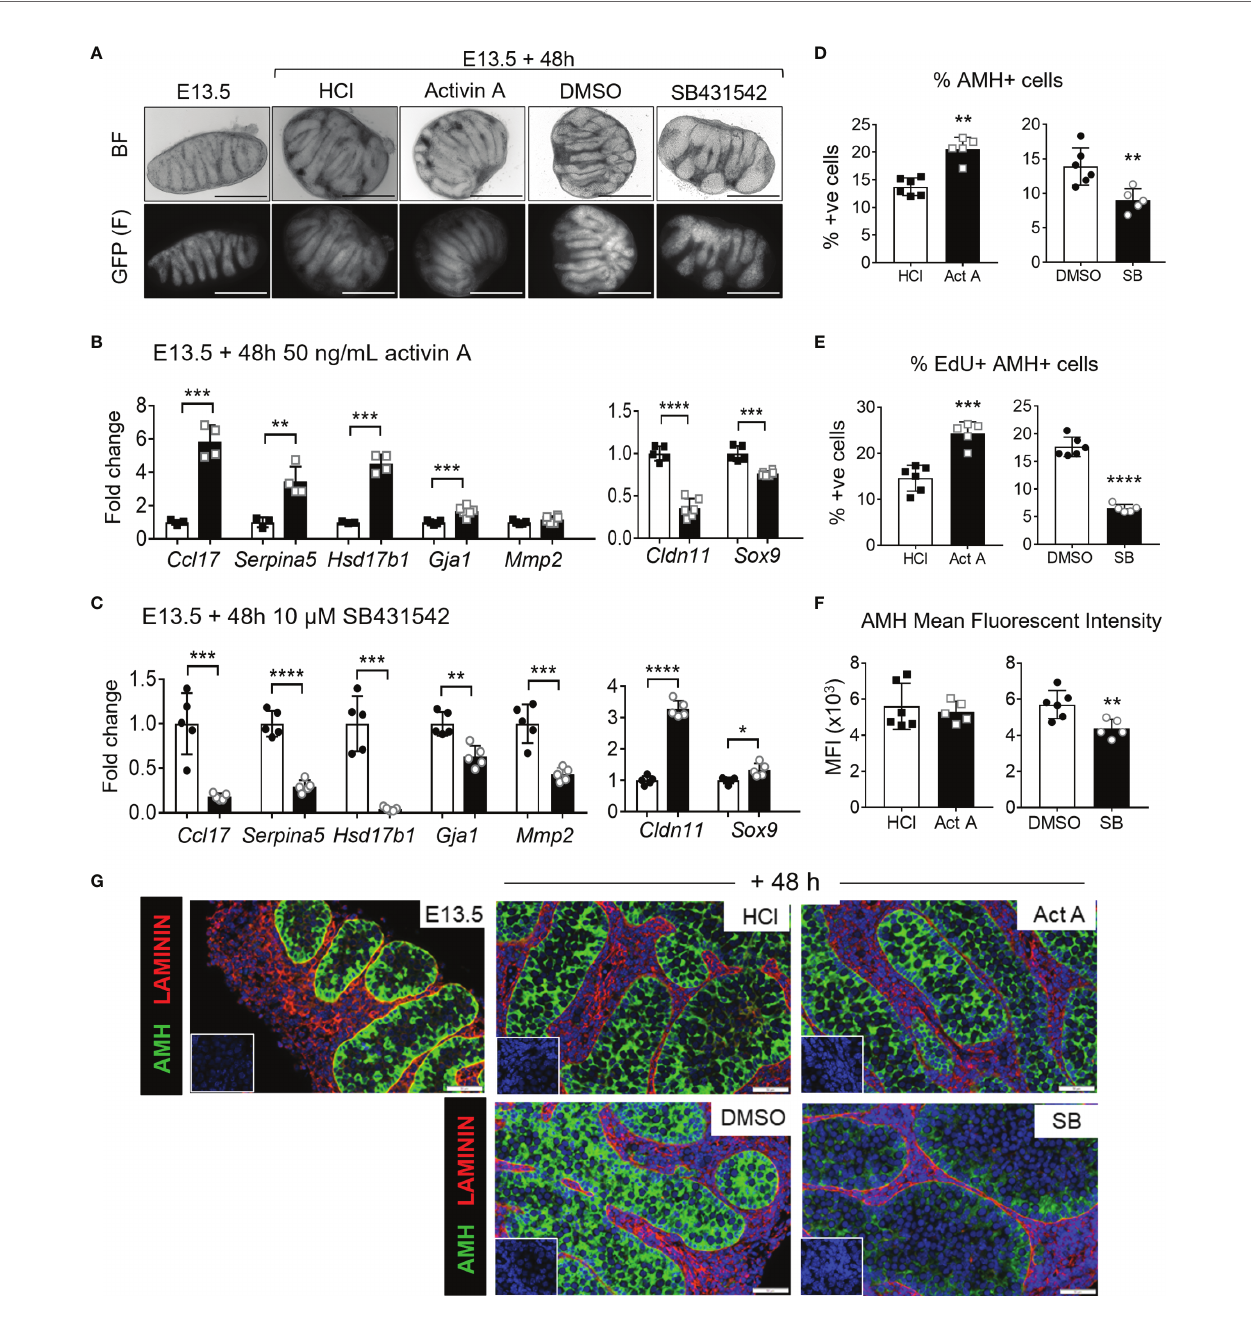
FIGURE 5 | Acute activin A and SB431542 effects on fetal testicular somatic cells. E13.5 testes were cultured for 48 hours on membranes. (A) Representative bright fi eld (top panel) and fl uorescent (GFP, bottom panel) images of E13.5 testis and E13.5 testes cultured 48 h with 50 ng/mL activin A, 10 µM SB431542, or vehicle controls (HCl and DMSO respectively). (B) Somatic cell transcripts of individual testes (n=3-5 per group) cultured for 48 hrs with 50 ng/mL activin A (black bars) compared with control (white bars). (C) Somatic cell transcripts of individual testes (n=3-5 per group) cultured for 48 hrs with 10 µM SB431542 (black bars) compared with control (white bars). All transcripts were measured by qRT-PCR and data normalised to Canx housekeeper. (D – F) Flow cytometry analysis of dissociated E13.5 testes cultured with 50 ng/mL activin A or 10 µM SB431542 for 48 hrs compared with controls. Proportion of (D) AMH-positive (Sertoli) cells, (E) EdU-positive AMH-positive (proliferating Sertoli) cells, and (F) mean fl uorescent intensity (MFI) of AMH-positive population. (G) Representative images of AMH (green) and Laminin (red) immuno fl uorescence staining of 48hr-cultured E13.5 testes. Sections were counterstained with DAPI (blue) for nuclear detection and scale bar is 50 µm. All graphical data are presented as mean ± SD and signi fi cant differences determined by a Student ’ s t-test or Mann-Whitney test following the Shapiro-Wilk normality test and indicated by asterisk (*p < 0.05, **p < 0.01, ***p < 0.001, ****p <